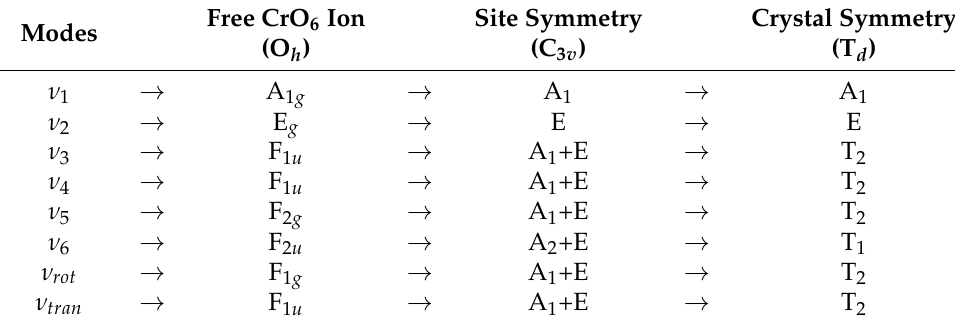
Table 4. Internal modes of CrO 6